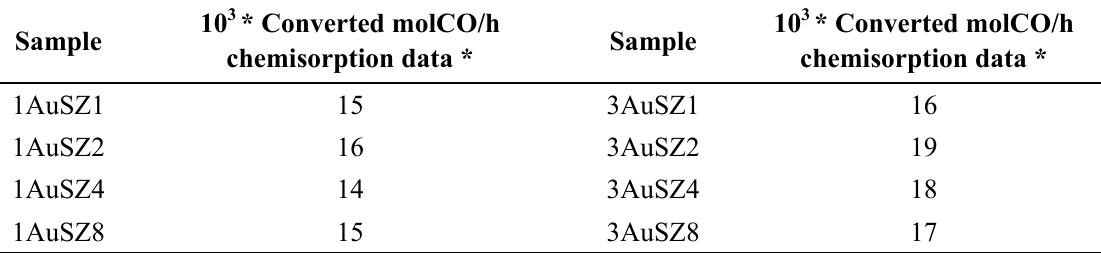
Table 2. Catalytic performances after 24